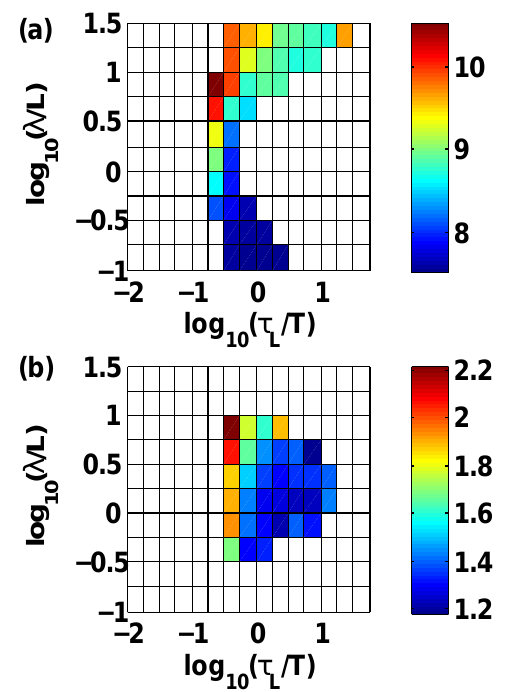
Fig. 7. Phytoplankton patch size B s × 10 − 5 km 2 as a function of Eulerian length scale (Eq. 12) and Lagrangian time scale τ L = 1 /3 for the Gaussian flow (a) and the altimetry flow (b) .